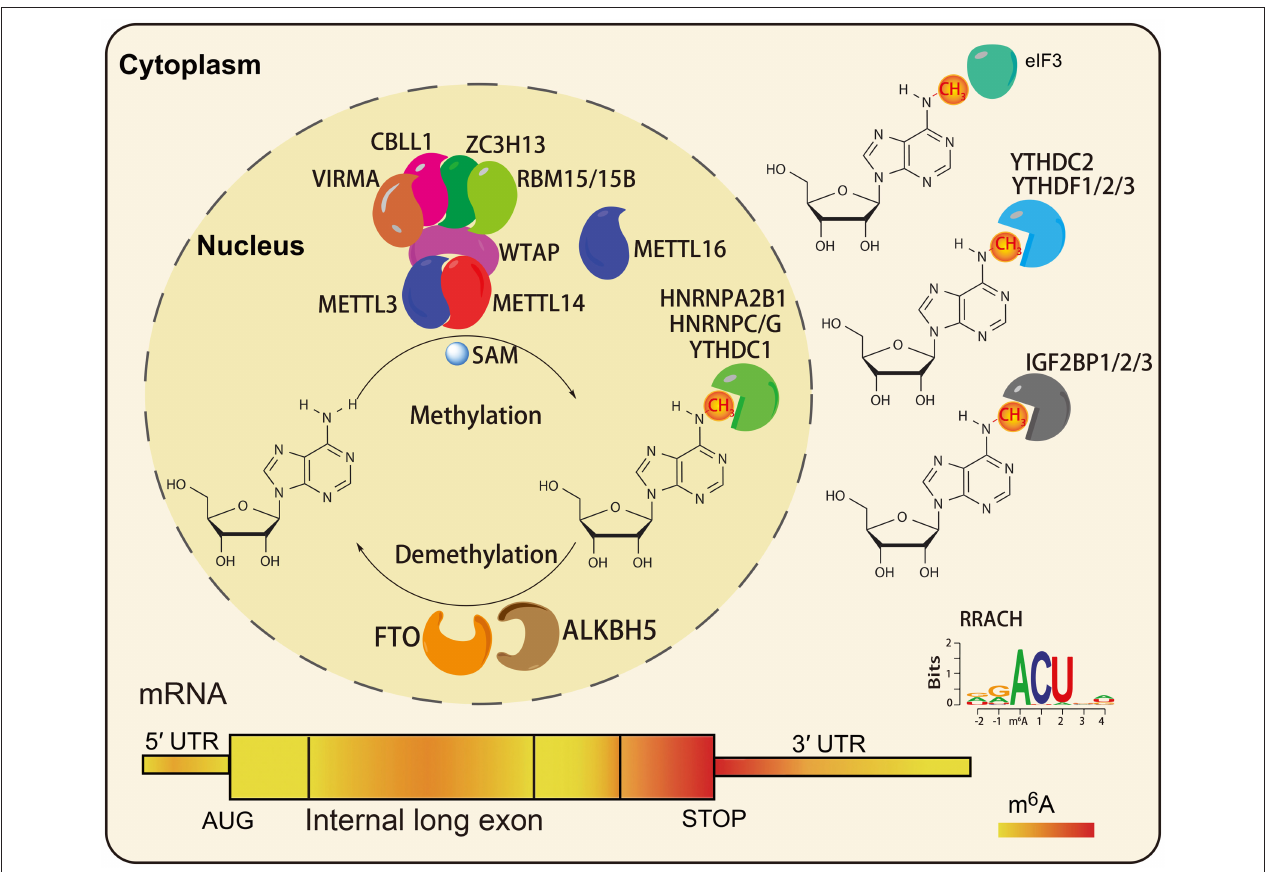
FIGURE 1 | The characteristics of RNA m 6 A modification. The m 6 A writers, erasers, and readers in eukaryotic cells (Shi et al., 2019). The preferences and density of RNA m 6 A modification in different regions of mRNAs (Fitzsimmons and Batista, 2019).